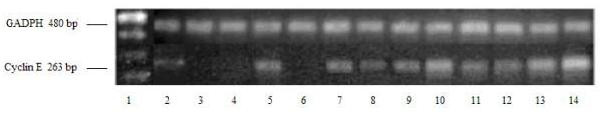
An ethidium bromide-stained 2% agarose gel for cyclinE gene amplification, lane 1: MW, lanes 2–4: normal cervical tissue samples, lanes 5–9: CIN cases, lanes 10–14: cases of invasive squamous cell carcinoma. Lanes 10, 13, 14 show cyclinE gene amplification.